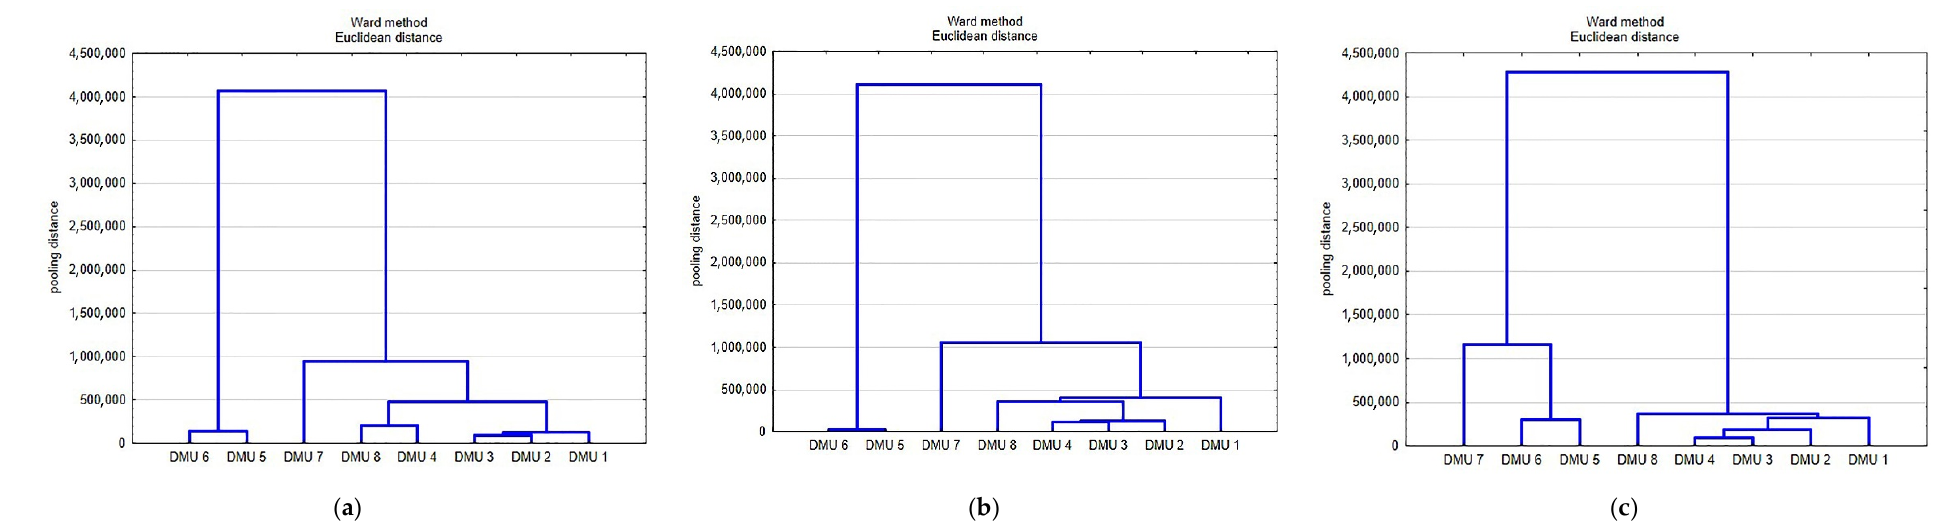
Figure 3. Hierarchical clustering of ecosystems according to the criteria of revenues, profits and assets for 2015–2021 (USD millions). Source: calculated by the authors based on the data [59–83]. Dendrograms of hierarchical clustering using the Ward method and Euclidean distance are shown in Figure 3. ( a )—2015–2019; ( b )—2020; ( с )—2021.